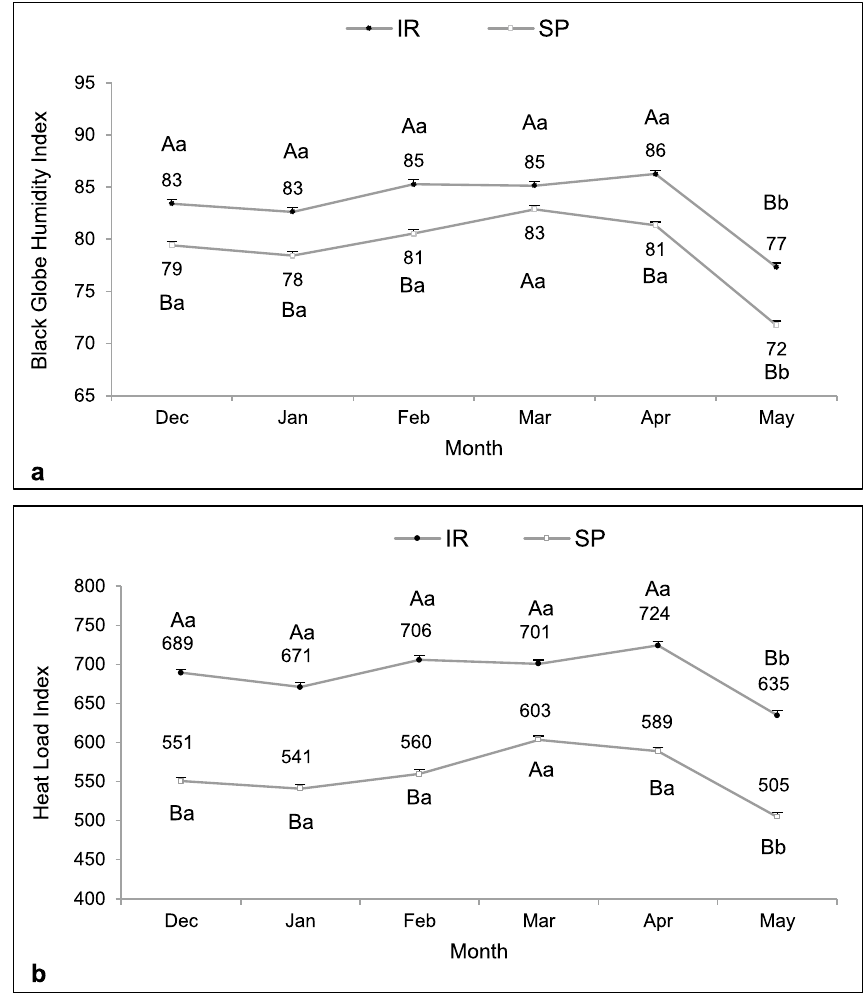
Figure 2. Microclimate characterization of pasture systems in silvopastoral (SP) or intensive rotational (IR) grazing systems according to black globe humidity index ( a ) and heat load index ( b ) registered from December 2015 to May 2016. There was an interaction between system and month on black globe humidity index and heat load index. A,B Different capital letters indicate a significant difference between systems. a,b Different lowercase letters indicate a significant difference between